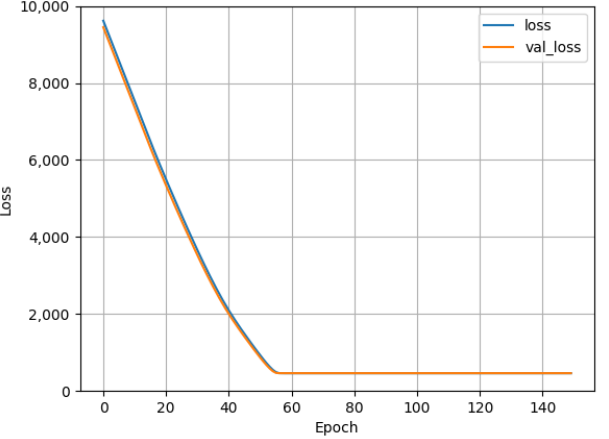
Figure 2. Sequential Neural Network training evolution. Prepared by the authors.